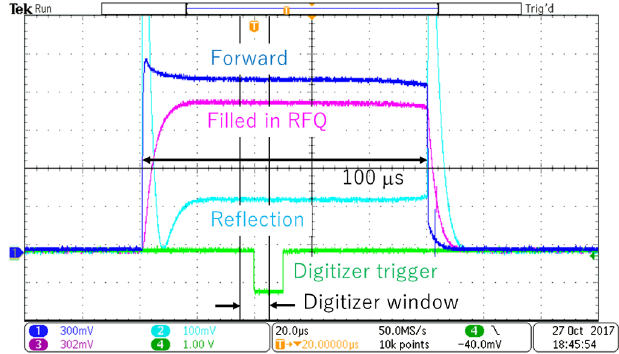
FIG. 2. Radio-frequency pulses input (Forward) into, reflected from, and filled in the RFQ. The digitizer window for the beam detector is also